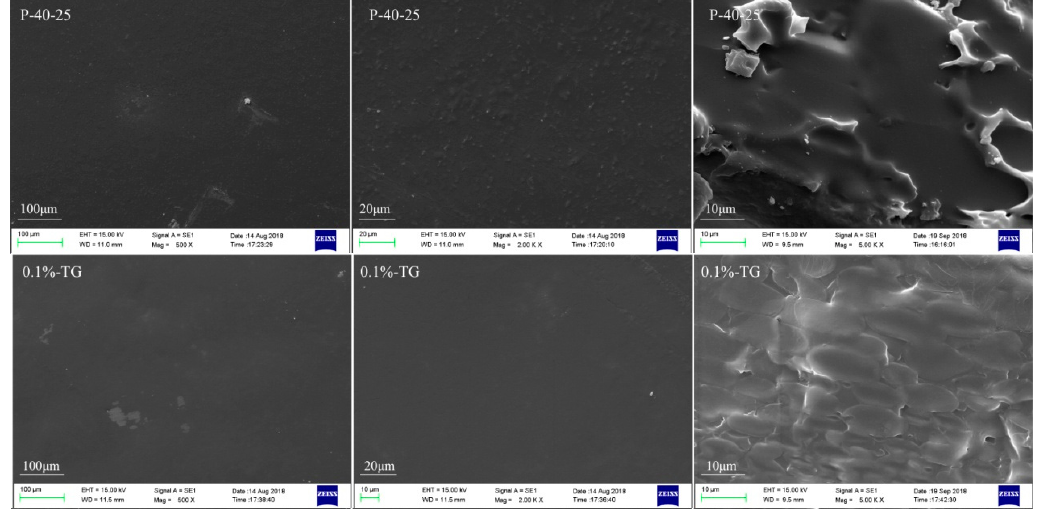
Figure 1. Representative SEM images revealing the surface morphologies ( left , 500×; center 2000×) and the fracture morphologies ( right , 5000×) of the blend films.